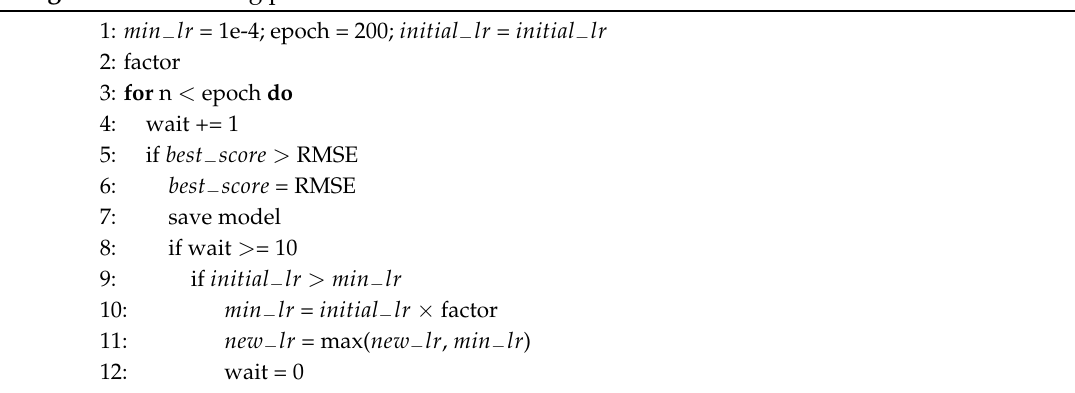
Algorithm 1: Training